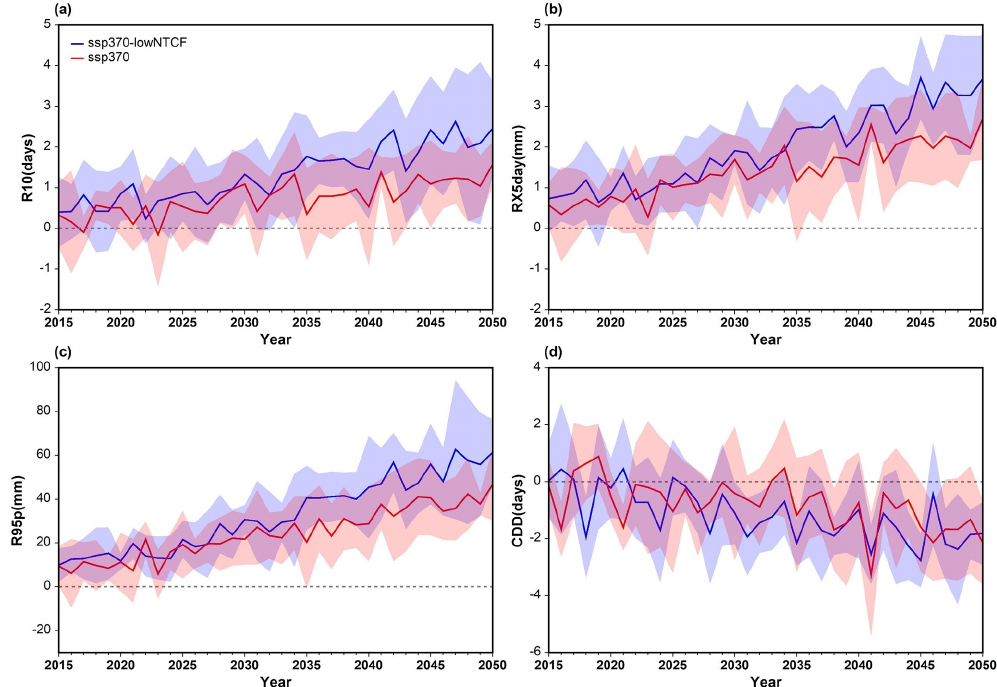
Figure 9. Time series of changes in annual mean heavy precipitation (R10; a ), maximum consecutive 5d precipitation (RX5day; b ), total wet-day precipitation (R95p; c ), and consecutive dry days (CDDs; d ) averaged over Asia under the SSP3-7.0 (red) and SSP3-7.0-lowNTCF (blue) scenarios from 2015–2050 relative to 1995–2014. The red and blue shading represents the ± 1 standard deviations across models.